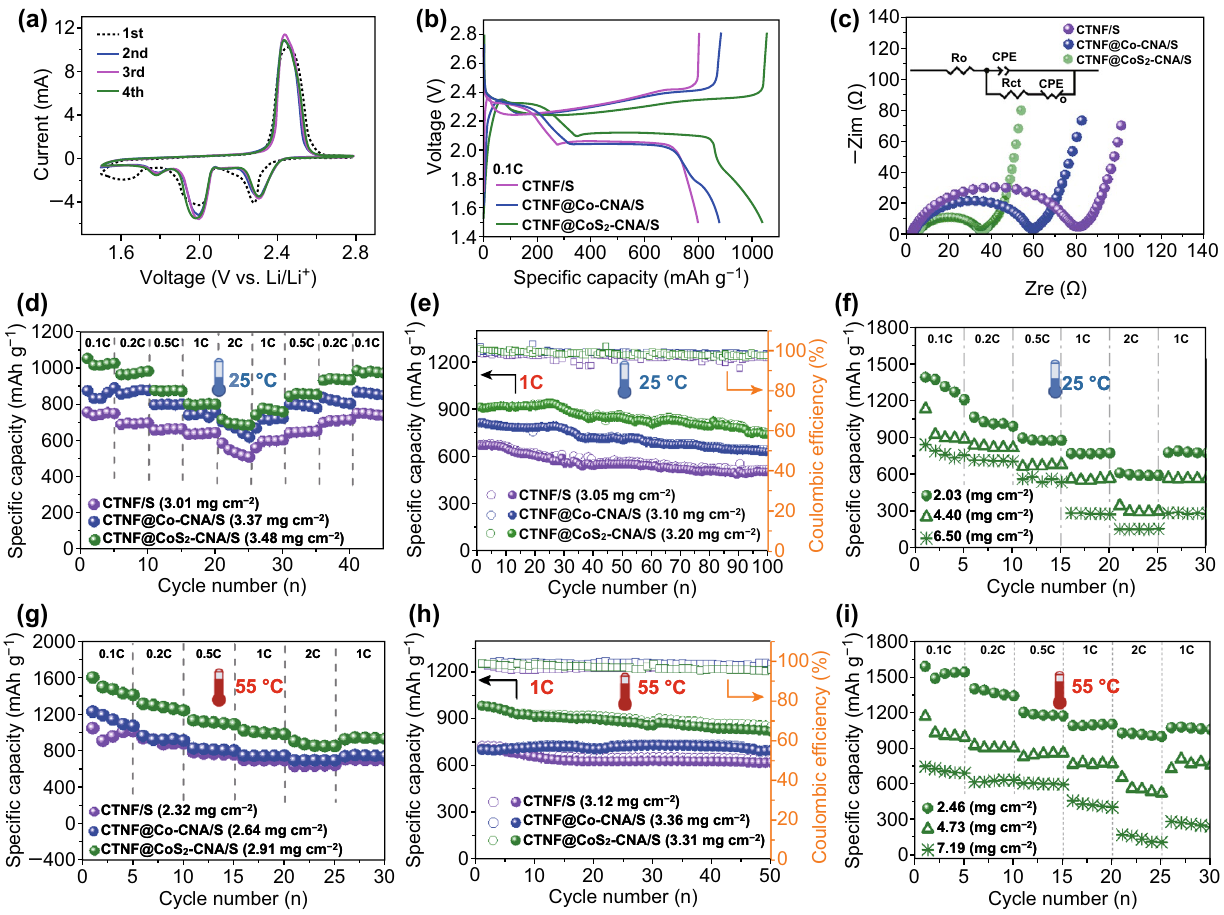
Fig. 4 a CV curve of CTNF@CoS 2 –CNA/S electrode. b The galvanostatic charge/discharge profile of three electrodes at 0.1 C. c Nyquist plots of three fresh cells. Electrochemical performance comparison of three electrodes at room temperature: d rate and e cycling performance at 1 C. f Rate performance of CTNF@CoS 2 –CNA/S electrode with different sulfur content. Electrochemical performance comparison of three electrodes at high temperature: g rate and h cycling performance at 1C. i Rate performance of CTNF@CoS 2 –CNA/S electrode with different sulfur